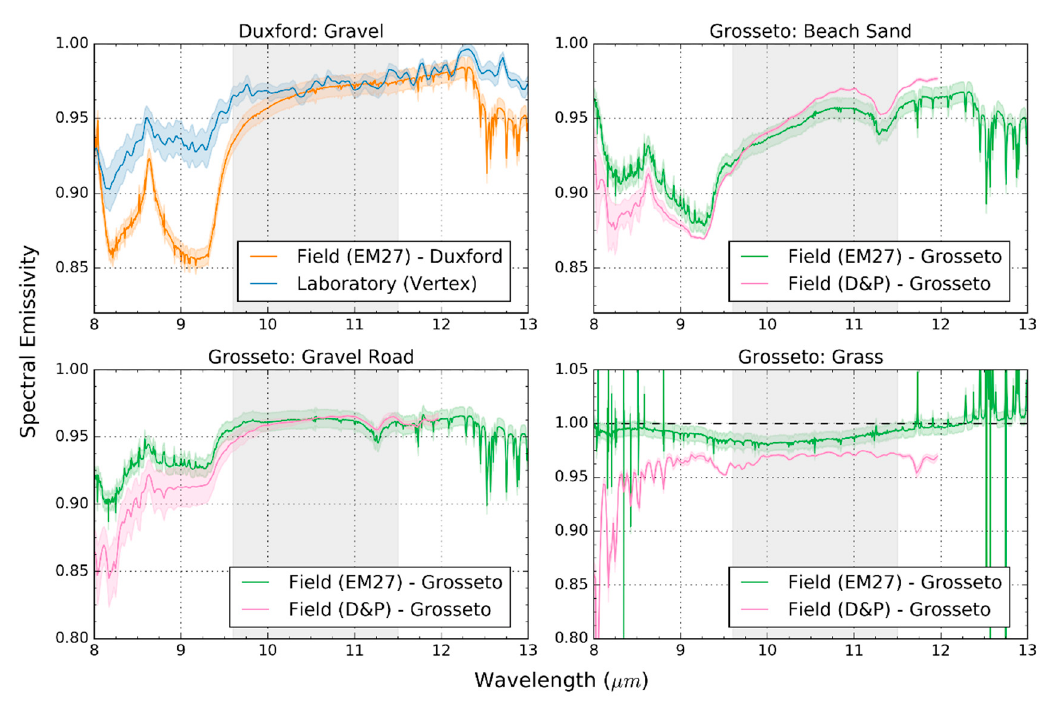
Figure 11. From top left clockwise, spectral emissivity measurements of (i) gravel from Duxford, (ii) beach sand in Grosseto, (iii) the sandy gravel drive in Grosseto, and (iv) short grass in Grosseto. Measurements were made using a Bruker Vertex 70 laboratory setup, a Designs and Prototypes µ FTIR spectrometer (D&P) operated in the field, and a Bruker EM27 also operated in the field. Values are the mean of all measurements, with the surrounding shaded area indicating the corresponding uncertainty as detailed in Section 3.1. The numbers of measurements made of each sample were listed in Table 4. Grey shaded area indicates the spectral range of the Heitronics KT15.85 IIP radiometer used for the emissivity box measurements.